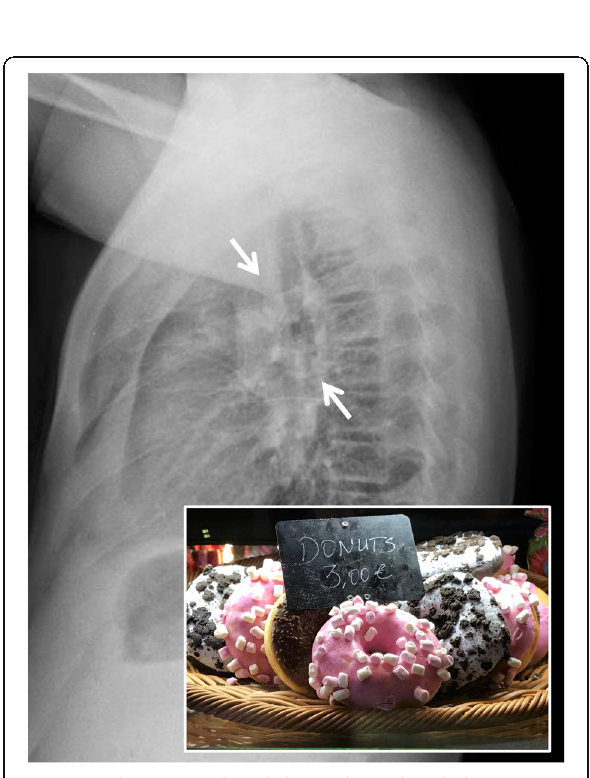
Fig. 9 Doughnut sign. A lateral chest radiograph with the “ doughnut sign ” : the white arrows clearly demonstrate the presence of a white radiopaque ring at hilar region. It is created by enlarged lymph nodes at hilar and subcarinal region, located around intermedius bronchus, and normal profiles of right and left pulmonary arteries and aortic arch anteriorly and superiorly. This radiopaque ring resembles the appearance of a doughnut — as appreciable in the embedded figure. This sign could be suggestive of lymphadenopathy — in case of tuberculosis